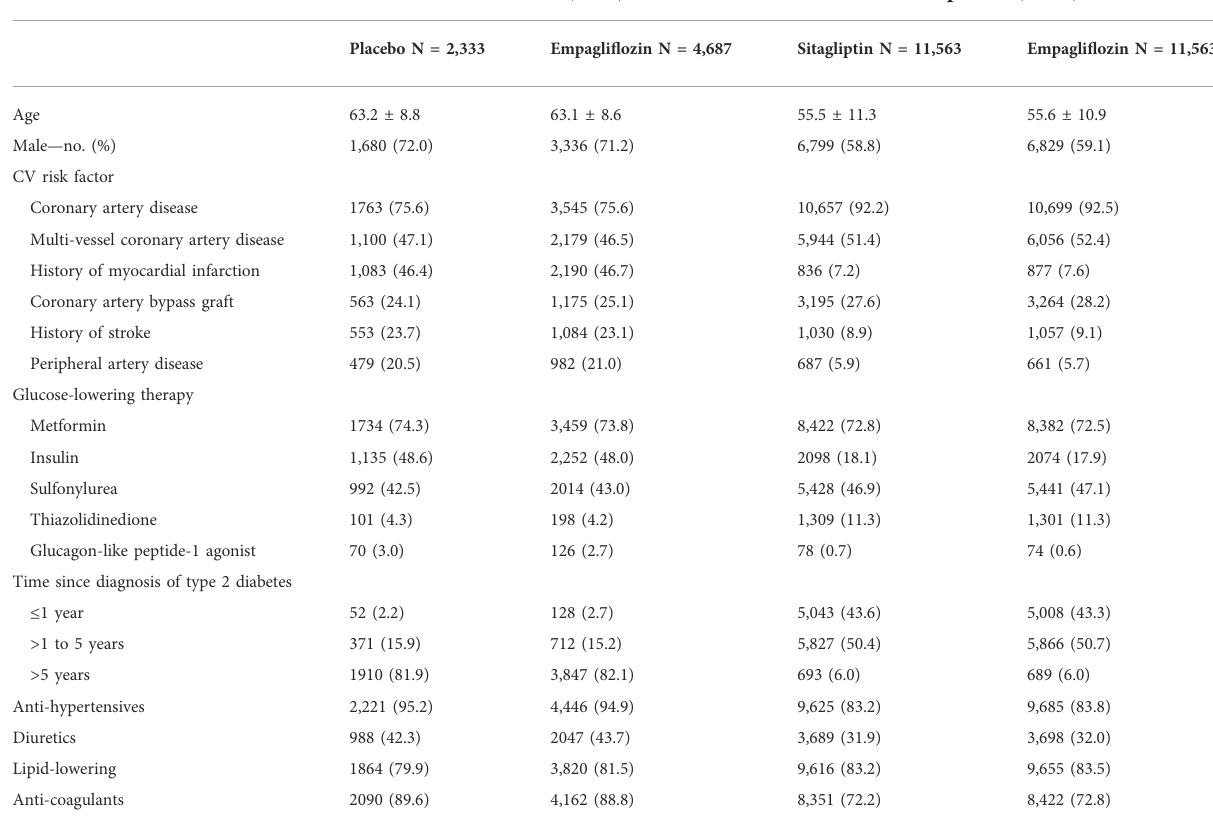
TABLE 2 Comparison of baseline characteristics between RCT and RWE.